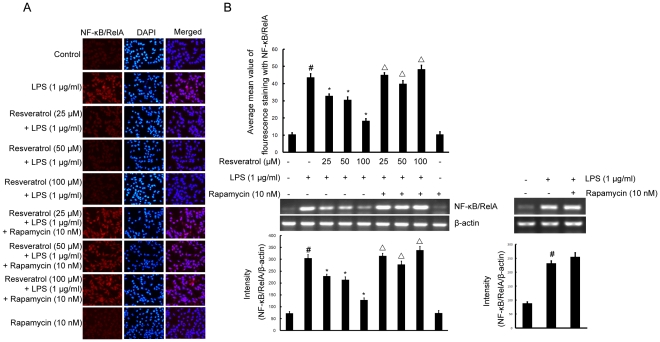
mTOR is required for resveratrol-inhibited expression of NF-κB/RelA protein and mRNA induced by LPS in BV-2 cells.Panel A shows the immunofluorenscence images for protein expression of NF-κB/RelA and Panel B shows the corresponding mRNA data. The relative mRNA level was quantified by scanning densitometry and normalized to β-actin mRNA. Note the up-regulated protein and mRNA expression of NF-κB/RelA by LPS is suppressed by different concentrations of resveratrol; however, in cells pretreated with mTOR inhibitor rapamycin, the suppressive effect of resveratrol is abrogated. The values shown are mean ± SEM of data from three independent experiments. #Significant compared with control alone, p<0.05. *Significant compared with LPS alone, p<0.05. ▵Significant compared with resveratrol+LPS, p<0.05.